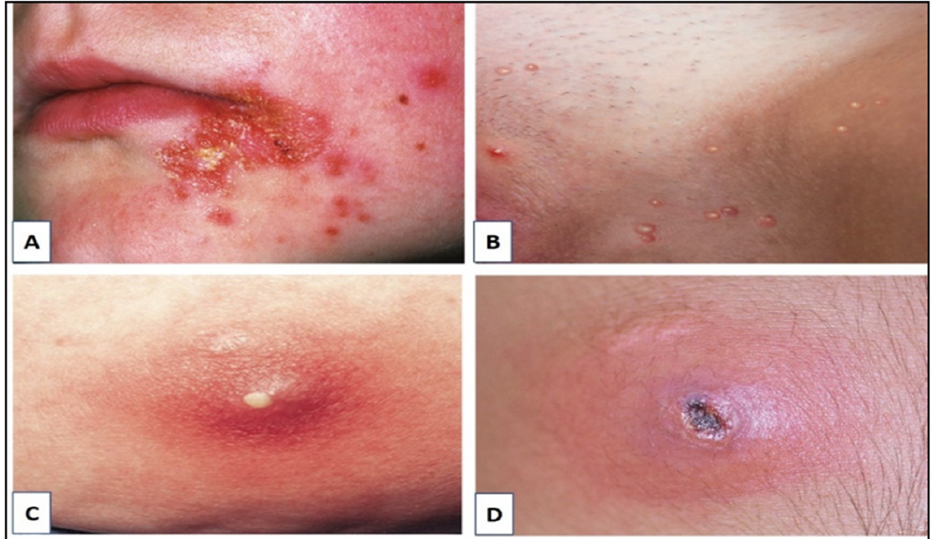
Figure 2. Common skin infections caused by S. aureus: A, Impetigo ; B, Folliculitis (Selk and Wood, 2019); C, Boil; D, Skin